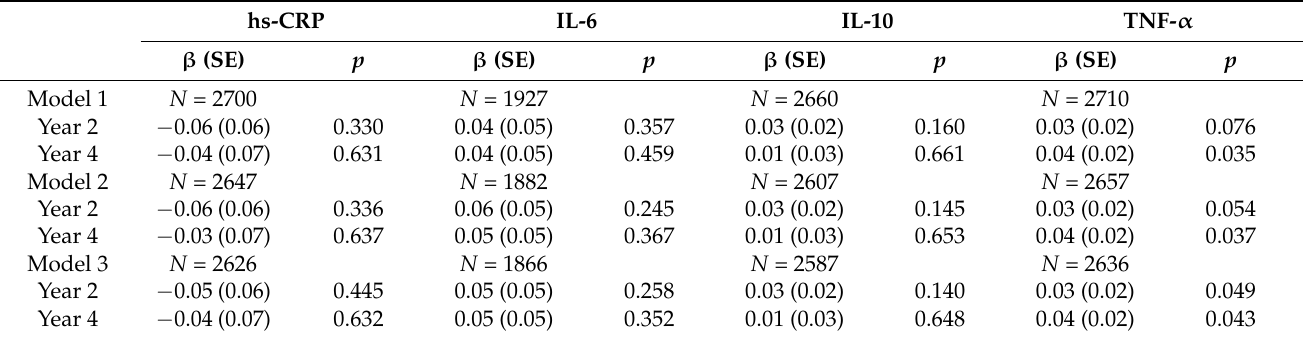
Table 3. Effects of marine n -3 fatty acids on log-transformed inflammatory